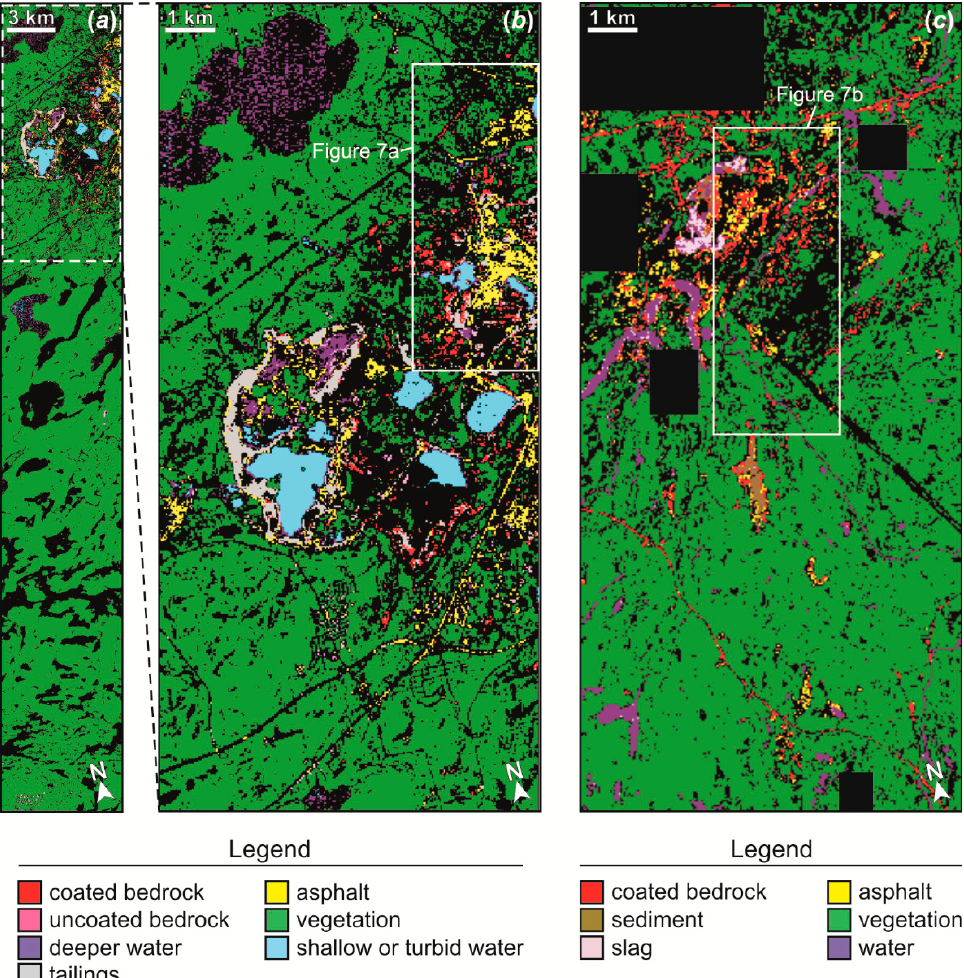
Figure 9. Maps of black coatings and other classes of interest for areas near the Copper Cliff ( a , b ) and Coniston ( c ) smelters, based on SAM classification of the nine-channel multispectral databases generated from Hyperion images. Areas affected by cloud cover in the Coniston study area are masked by black rectangles. Image footprints and smelter stack locations are given in Figure 1. Selected lakes and other landmarks are labeled in Figures 6 and 7.